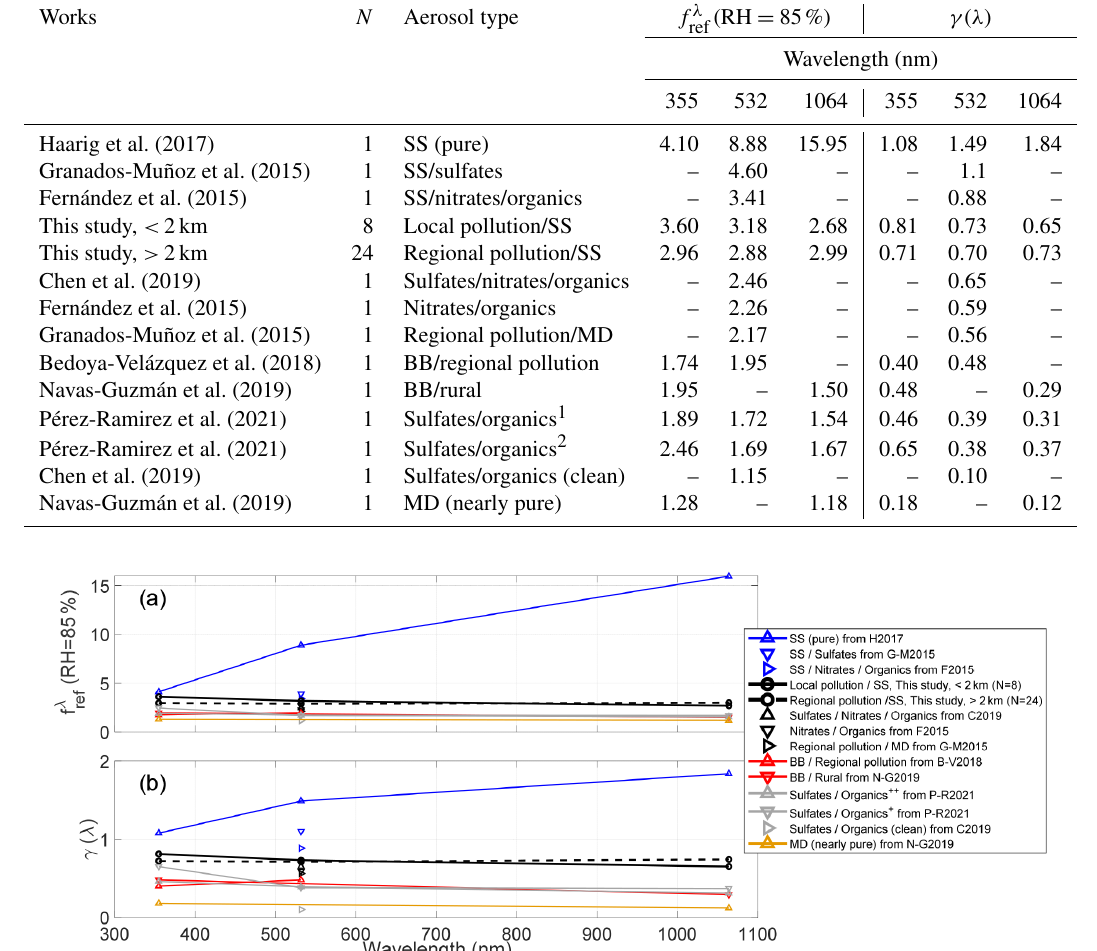
at RH = 85% and RH ref = 40% and γ ( λ ) from the literature and from this study (in bold font). Values are listed in a decreasing Table 3. f λ ref order of the values at λ = 532nm. SS stands for sea salt, MD for mineral dust and BB for biomass burning. N is the number of cases. Organics 1 indicates a greater amount of organics compared to Organics 2 .